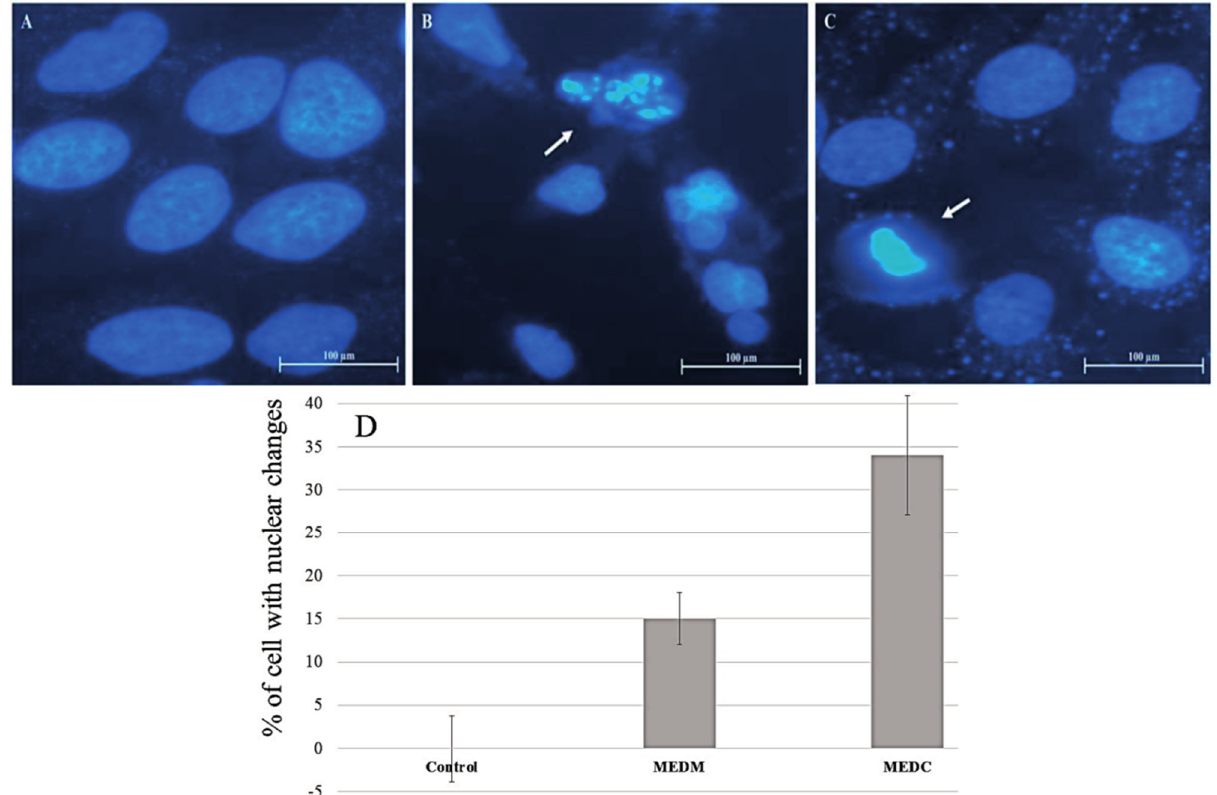
Figure 4. Morphological changes of HeLa cells after treatment with ME for 24 h followed by DAPI staining. ( A ) Fluorescence microscope photographs of untreated cells; ( B ) cells treated with 0.2 mg/mL MEDM and ( C ) cells treated with 0.2 mg/mL MEDC; ( D ) DAPI staining quantification. Arrows indicate apoptotic bodies of nuclear fragmentation and chromatin condensation (B and C, respectively). Magnification